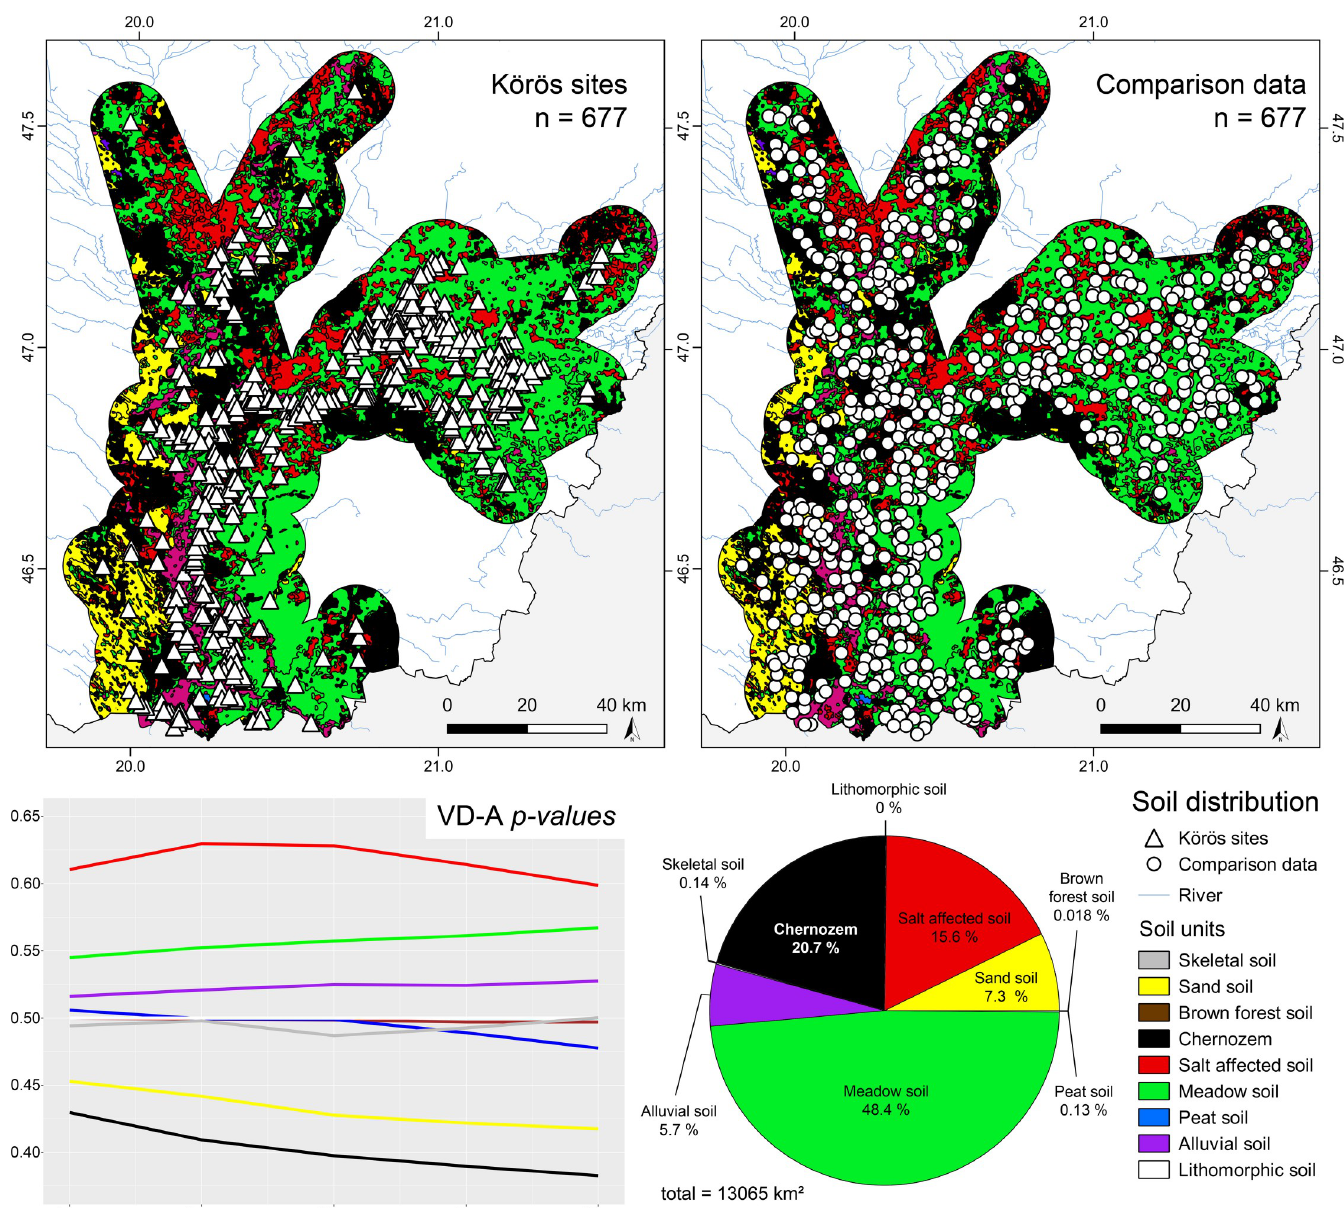
Fig 7. Distribution of the Ko¨ro¨s ‘culture’ sites (n = 677), the random comparison data sample (n = 677), and the soil units in the study area. The p-values of the VD-A statistics show the significant preferences of salt affected soils, meadow soils, and alluvial soils and further highlight the strongly significant avoidance of Chernozem soils and sand soils. The other soil units did not show significant preferences or avoidance of the Ko¨ro¨s ‘culture’ site occupation.